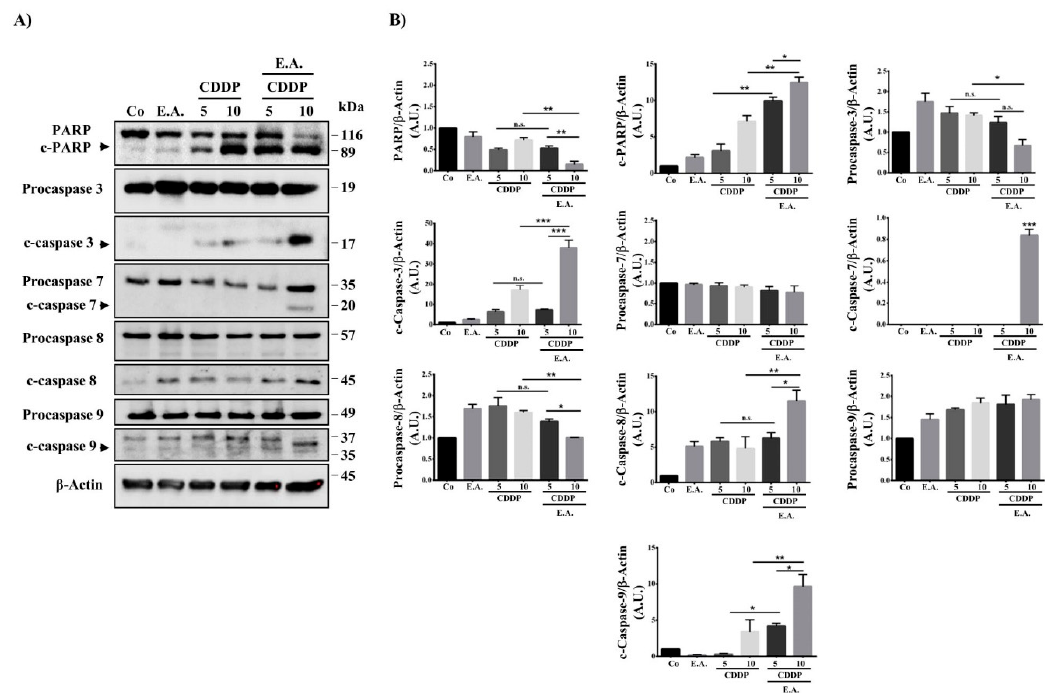
Figure 4. E.A./CDDP combination induced caspase activation in breast cancer cells. ( A ) Figure 4. E.A. / CDDP combination induced caspase activation in breast cancer cells. ( A ) Immunoblotting analysis of indicated proteins in 4T1 cells exposed for 48 h to the vehicle (Co) or to E.A. (6 μ g/mL), CDPP (5 and 10 μ M), or to the combination of E.A (6 μ g/mL) and CDDP (5 or 10 μ M).